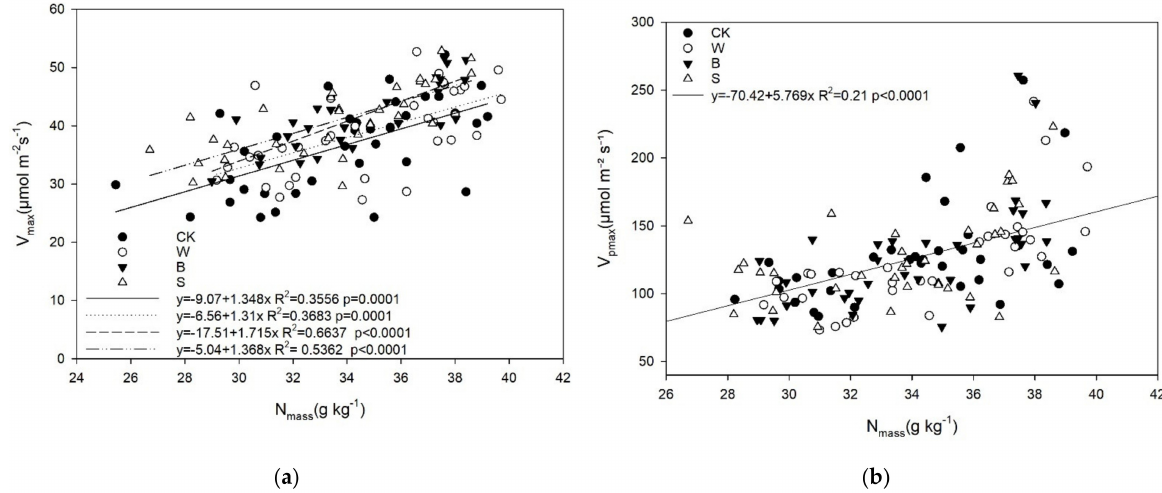
Figure 6. Fitting relationships between ( a ) V max , ( b ) V pmax , and N mass in different coverage